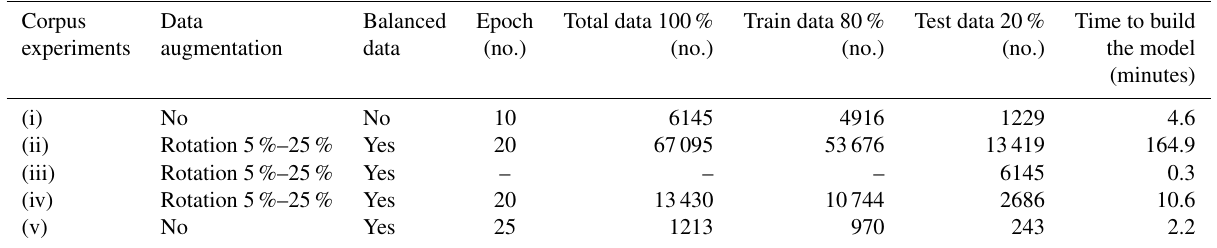
Table 3. Statistics related to the transfer learning experiments using AlexNet for hybrid events (HY), long period (LP), tectonic events (TC), tremors (TR), and volcano–tectonic (VT)